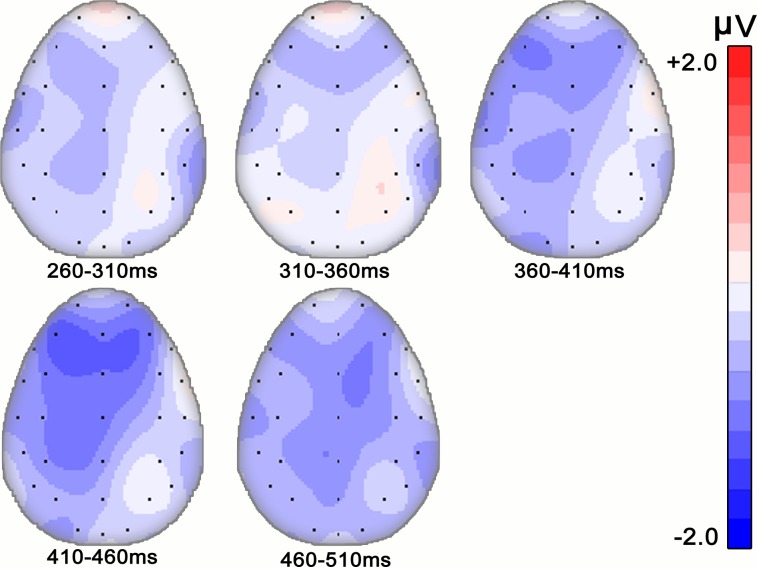
Time course of N400 effects in Experiment 1 (music major group).Difference-wave topography is shown in maps of 50ms duration from 260ms to 510ms.